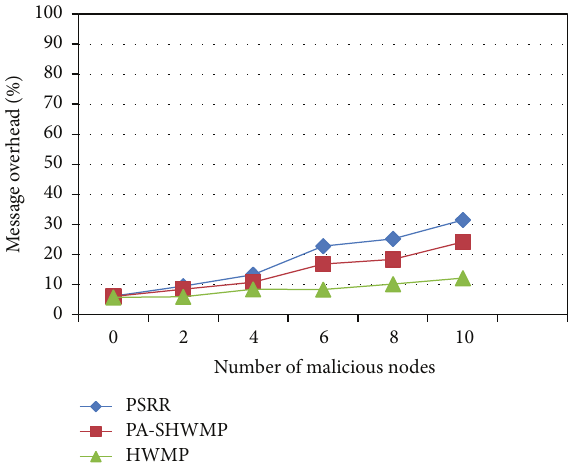
Figure 7: Message overhead versus number of malicious